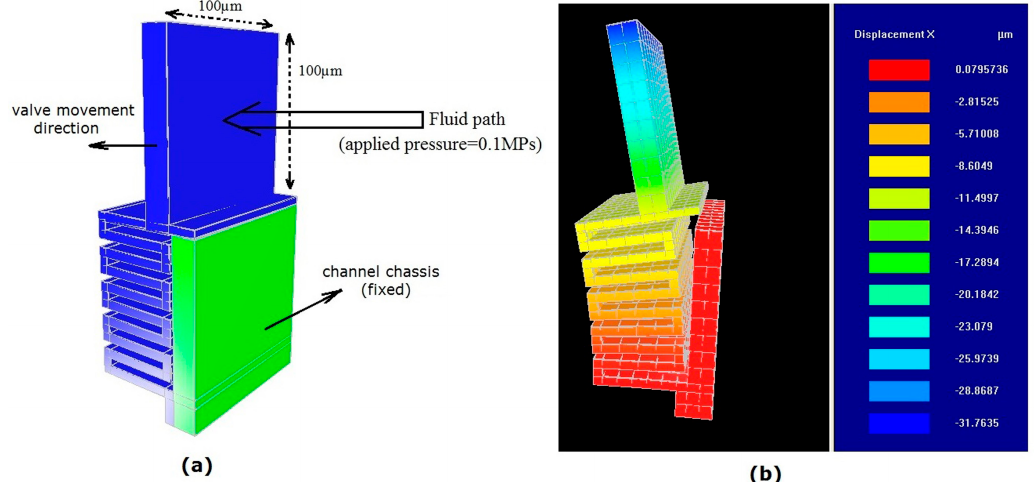
Figure 9. ( a ) Geometry of proposed check valve. ( b ) Simulation result showing 31.7 μ m displacement with an applied 1 mN pumping